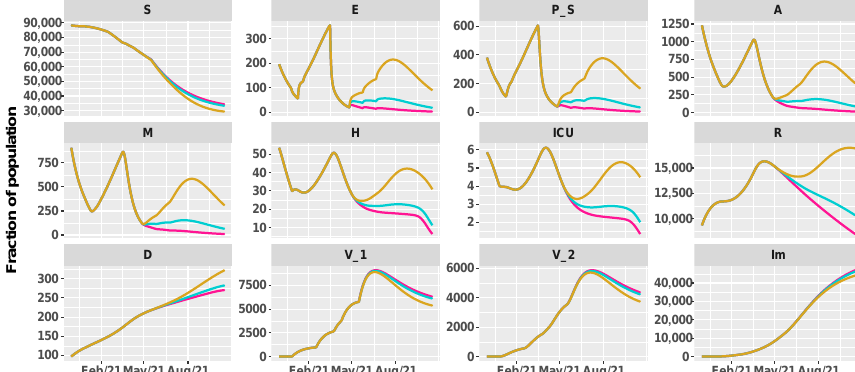
Figure 11. Projections of the epidemic evolution with a vaccination schedule of 500,000 first doses of vaccines per day in Italy (slow vaccination). Each line corresponds to a different reopening strategy, i.e., different values of transmission rate parameters b e and b 0 (yellow for high values, blue for medium values, and pink for low values.)